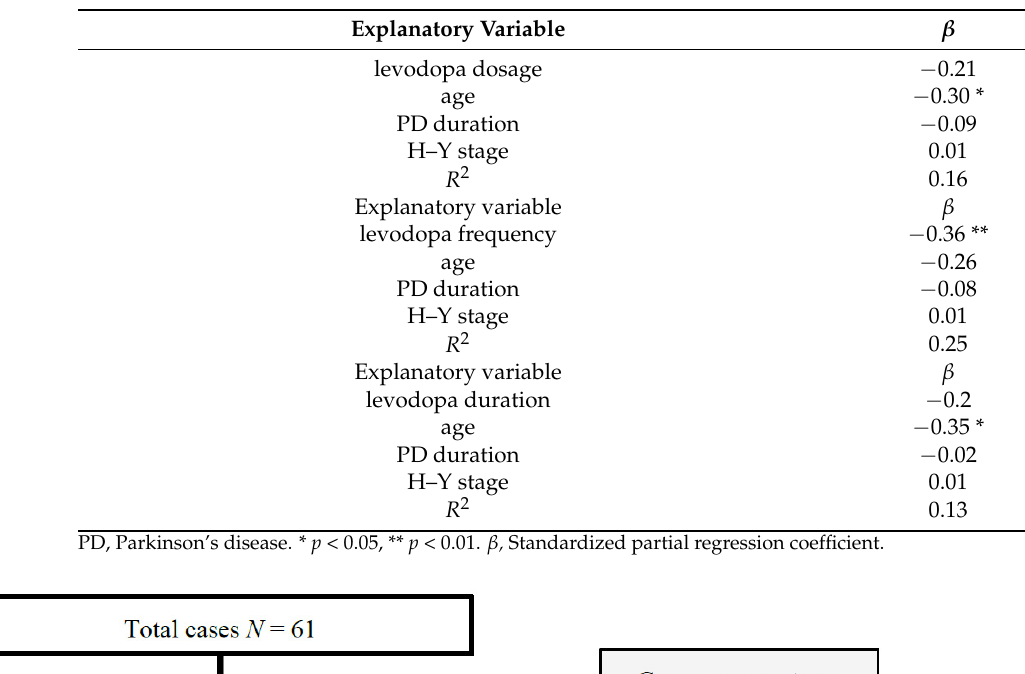
Table 3. Multiple regression analysis with zinc levels as objective variable in PD patients. Age, PD duration, and H-Y stage were added to the explanatory variables for analysis for each of levodopa dose, frequency, and levodopa duration.